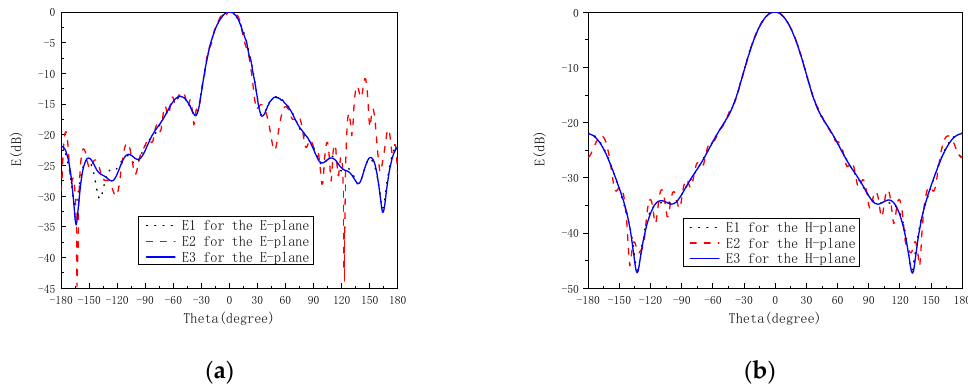
Figure 4. Pattern of the H-plane of the antenna. ( a ) E-plane; ( b ) H-plane.